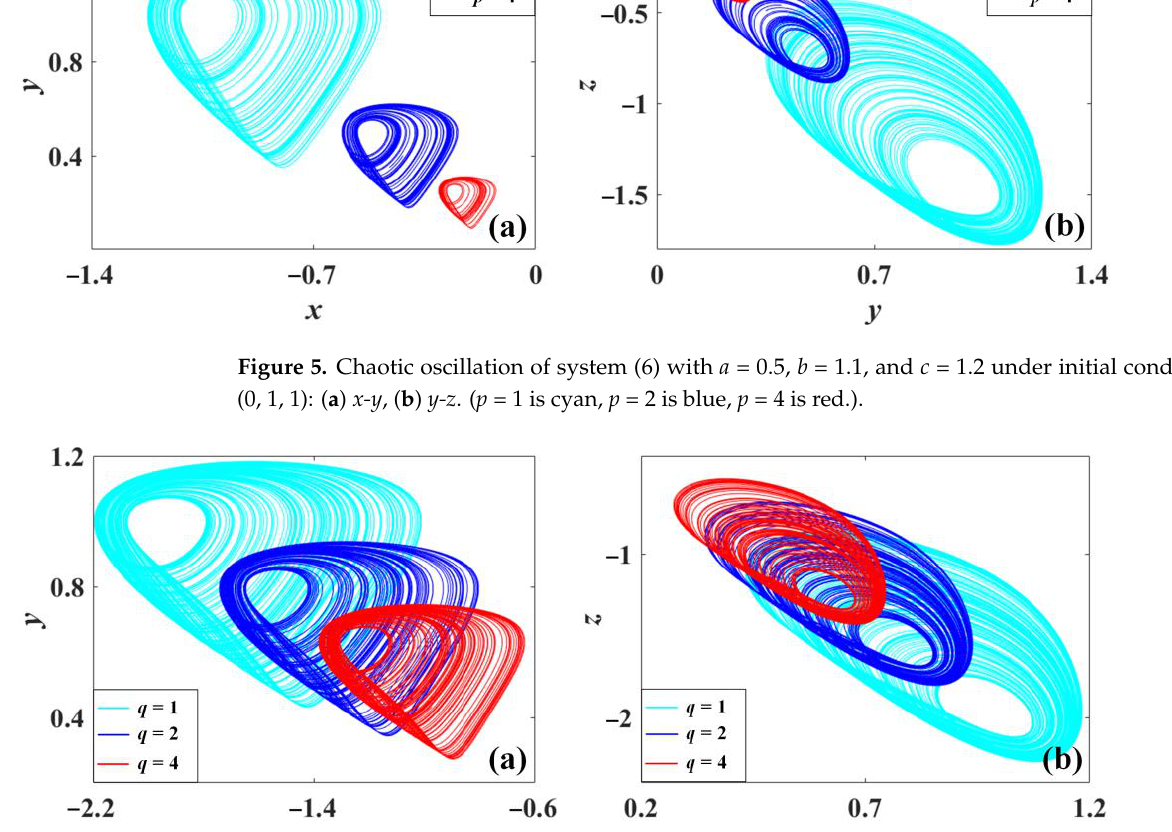
Figure 6. Chaotic oscillation of system (7) with a = 0.5, b = 0.6, and c = 1.2 under initial condition (0, 1, 0): ( a ) x-y , ( b ) y-z . ( q = 1 is cyan, q = 2 is blue, q = 4 is red.).